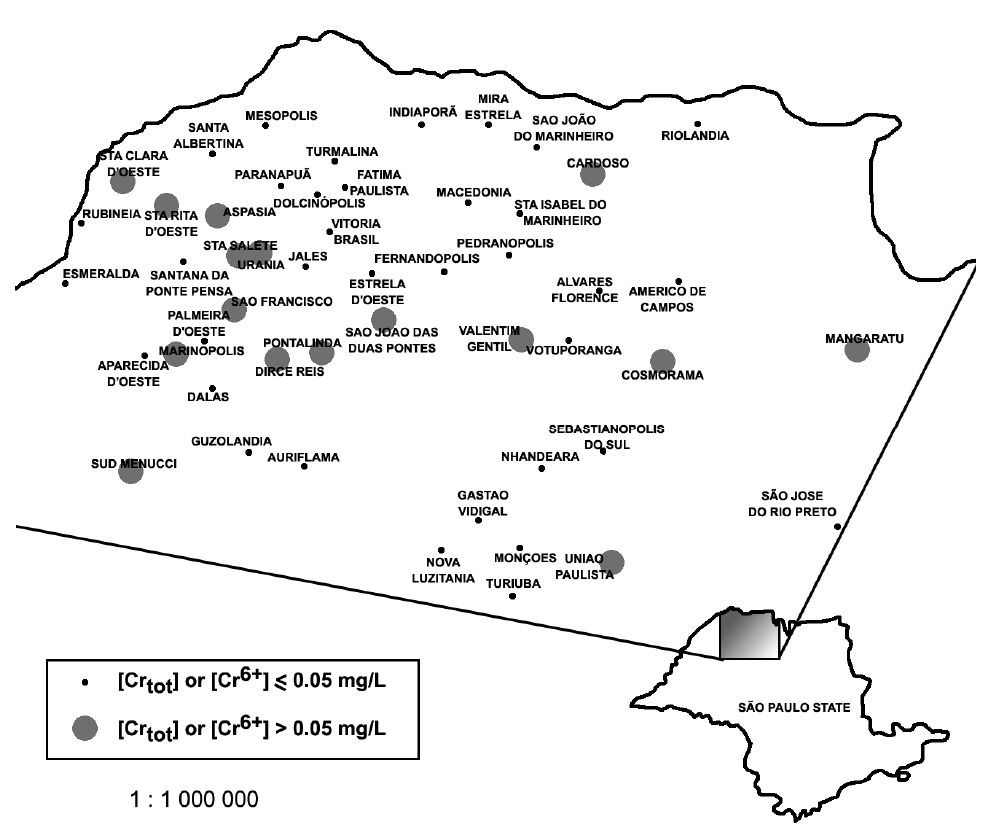
Fig. 2 – Distribution of chromium concentrations in space (modified from Almodovar and Pacheco